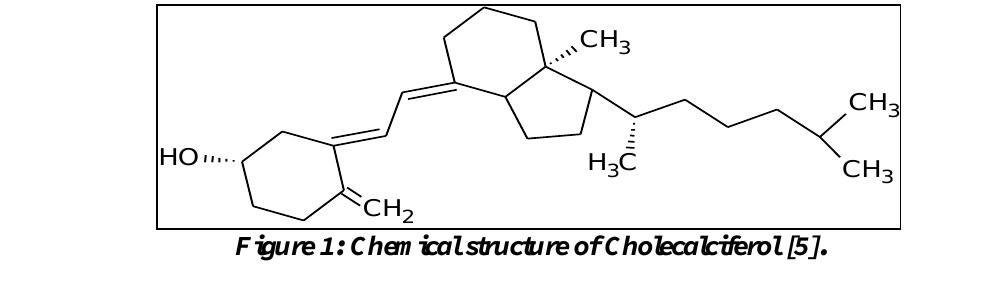
Figure 1: Chemical structure of Cholecalciferol